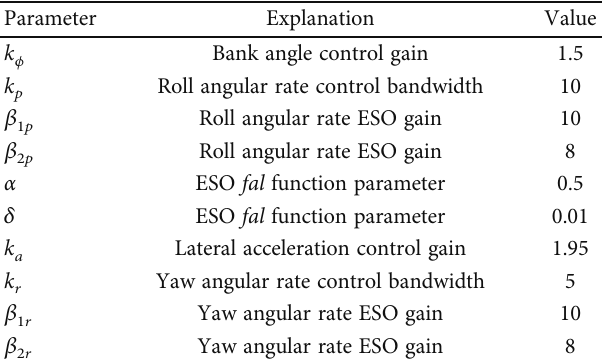
Figure 14: Phase margin and gain margin (median values are shown). (a) Gain margin at the breakpoints of the input and output. (b) Phase margin at the breakpoints of the input and output. Table 7: ESO and outer loop control parameters.